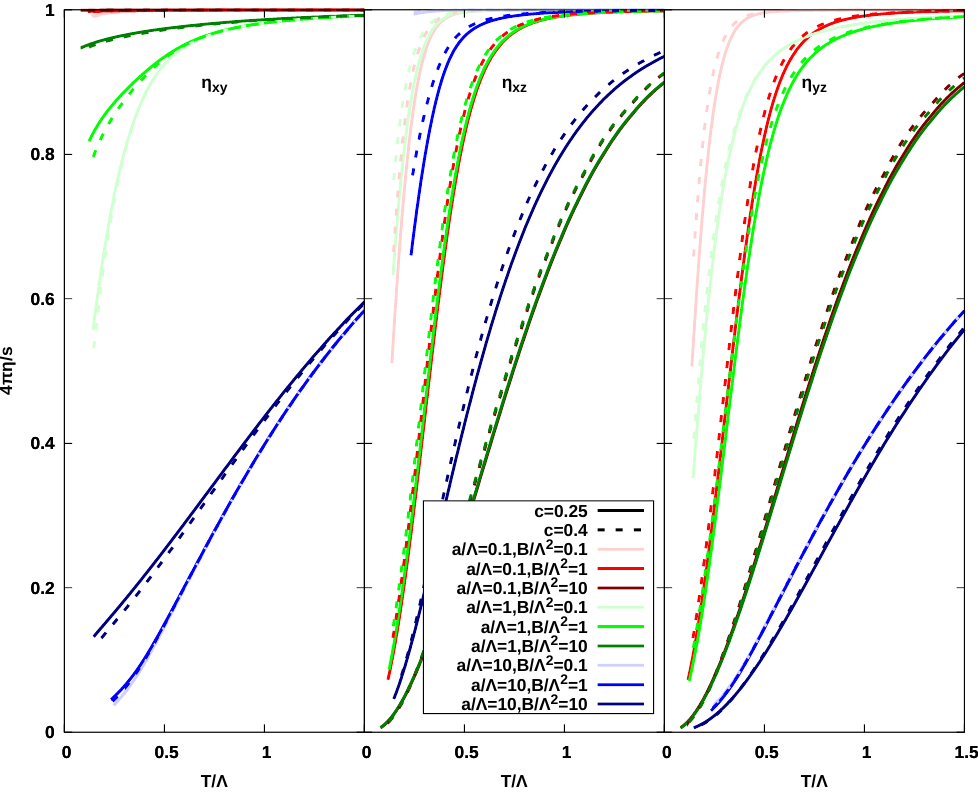
Figure 12 . Ratio between the components of the shear viscosity tensor and the entropy density for the case where the magnetic field (aligned along the z -direction) is perpendicular to the anisotropic deformation (introduced along the y -direction). All the plots are given as a function of temperature, in units of Λ ∼ 1 GeV, and cut off at the chiral transition temperature so they correspond to the chirally symmetric phase. The solid lines depict results for c = 0 . 25 , which we have kept for comparison, while dashed lines show the corresponding results for c = 0 . 4 . We observe all the same qualitative features for the two values of c , with some small visual distinction along the flow from the UV to the IR: while η generally decreases with the increase of c , both η and η increase xy xz yz at an intermediate regime of energies, while approaching roughly the same constants in the